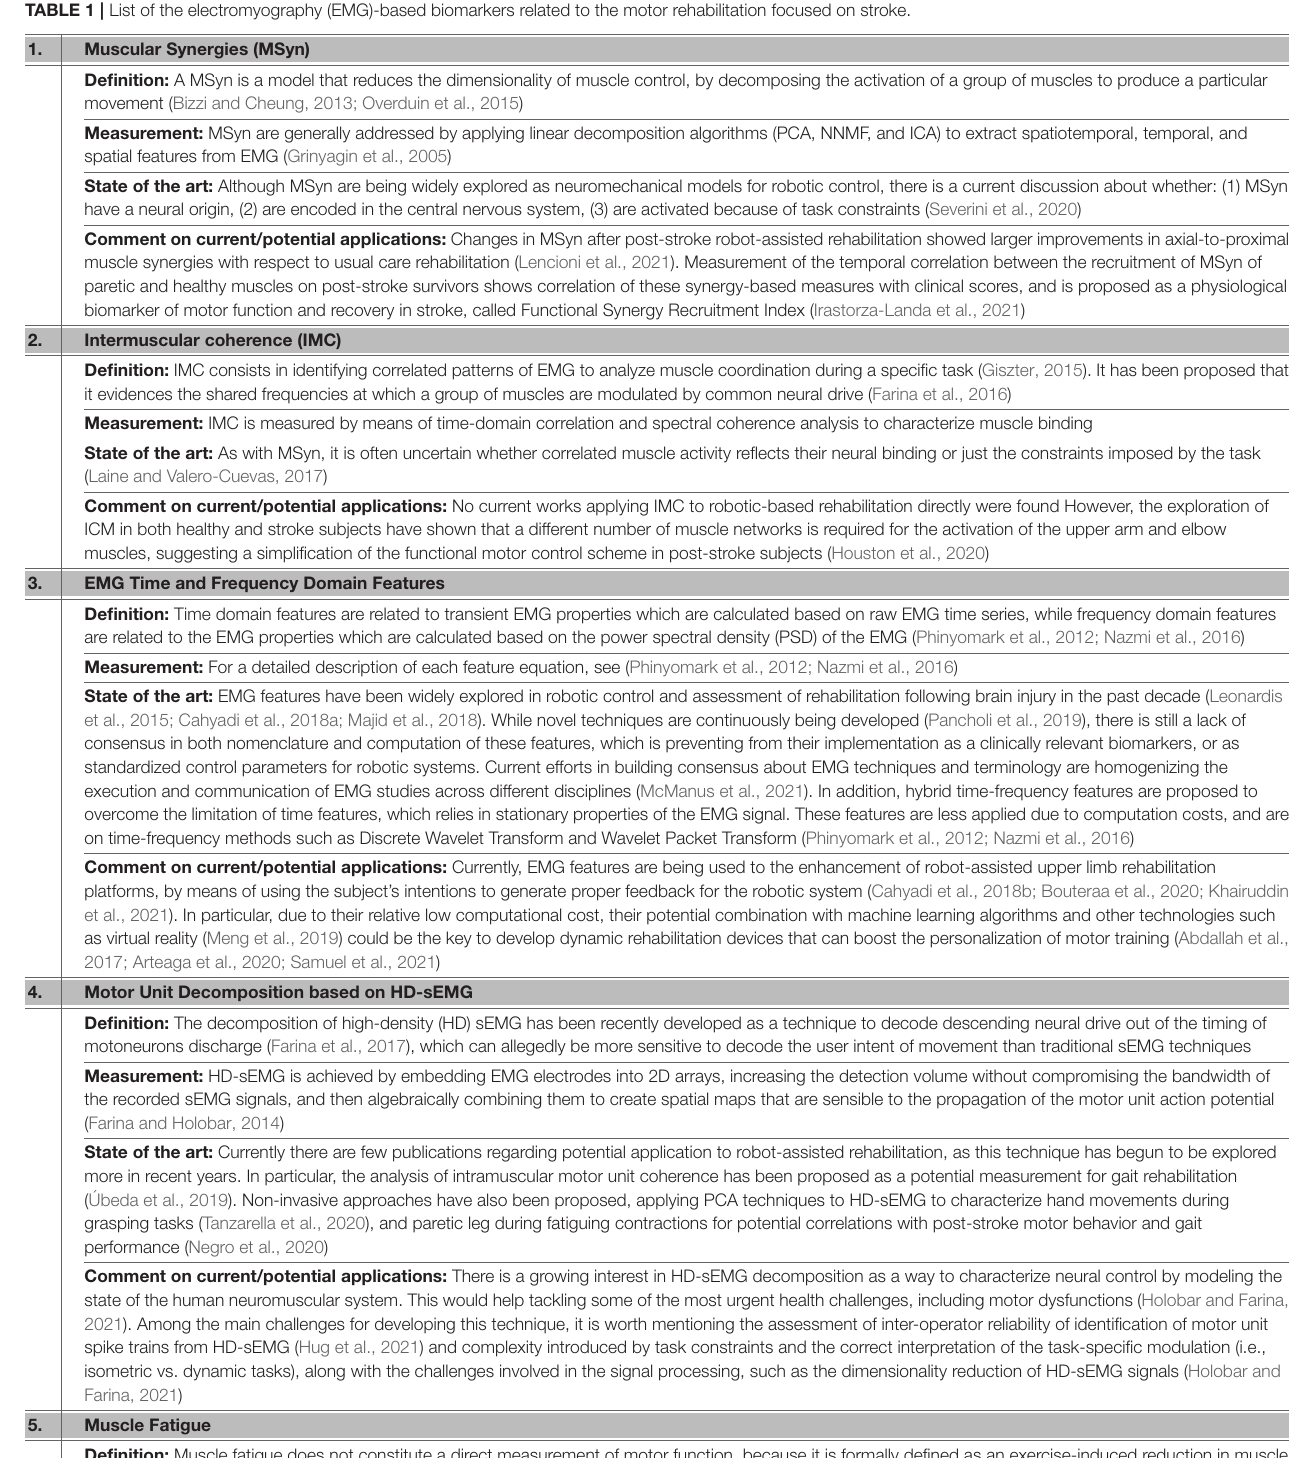
TABLE 1 | List of the electromyography (EMG)-based biomarkers related to the motor rehabilitation focused on stroke.